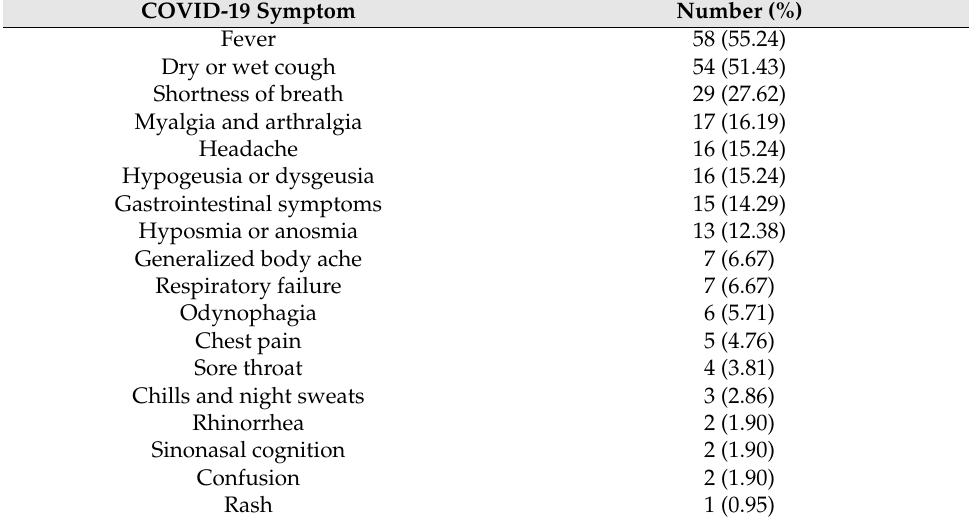
Table 3. COVID-19